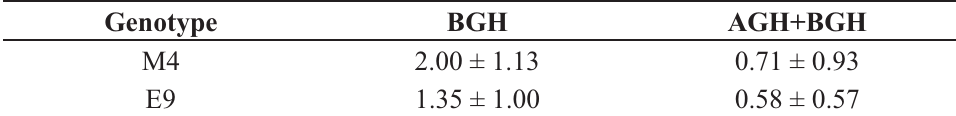
Table 1. Weight gain of Agriotes larvae (mean ± SE) in the different